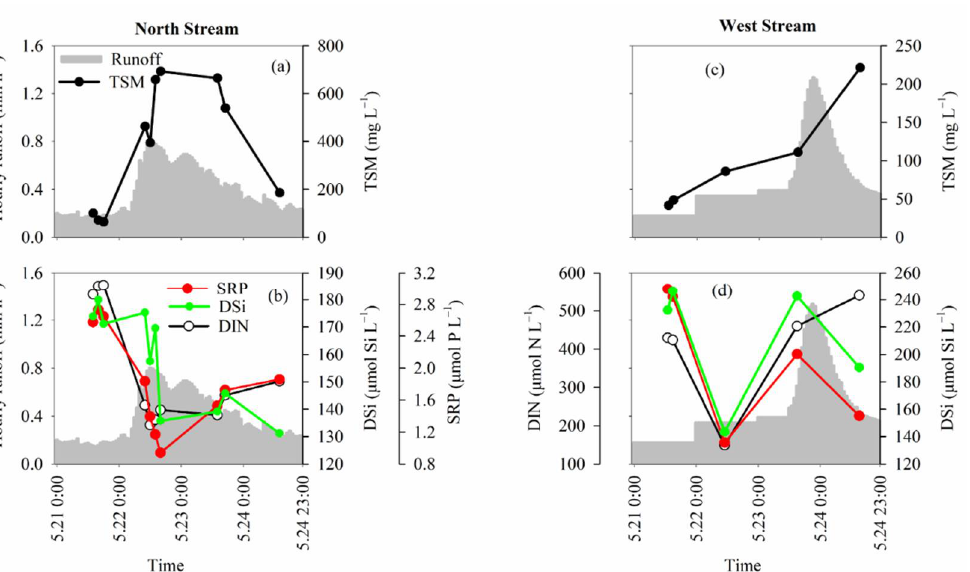
Figure 4. Temporal changes in TSM and nutrients during the rain event in the NS ( a , b ) and the WS ( c , d ). The gray shading represents the hourly runoff.